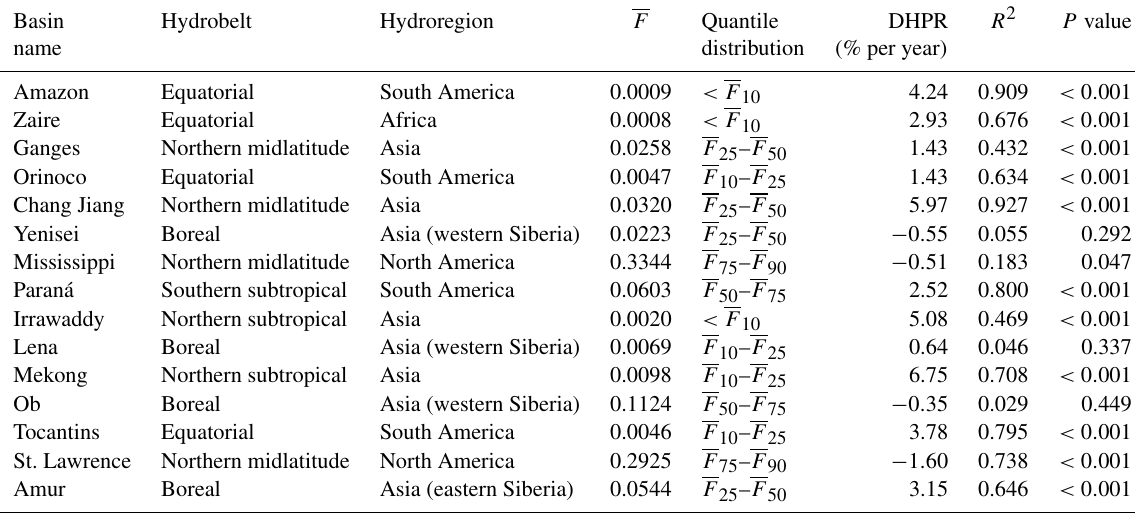
Table A1. Estimates of long-term average standardized human pressure on river systems F . River basins are ranked as a decreasing function of natural river discharge, Q . The first 15 river basins are examined. Basin name, hydrobelt, hydroregion, F and quantile distribution, DHPR values (% per year), coefficient of determination R 2 , and P values for Student’s t test are reported.